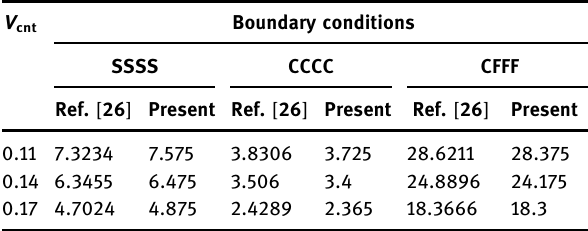
Table 3: Comparison of non - dimensional central de fl ection w ̄ = wE